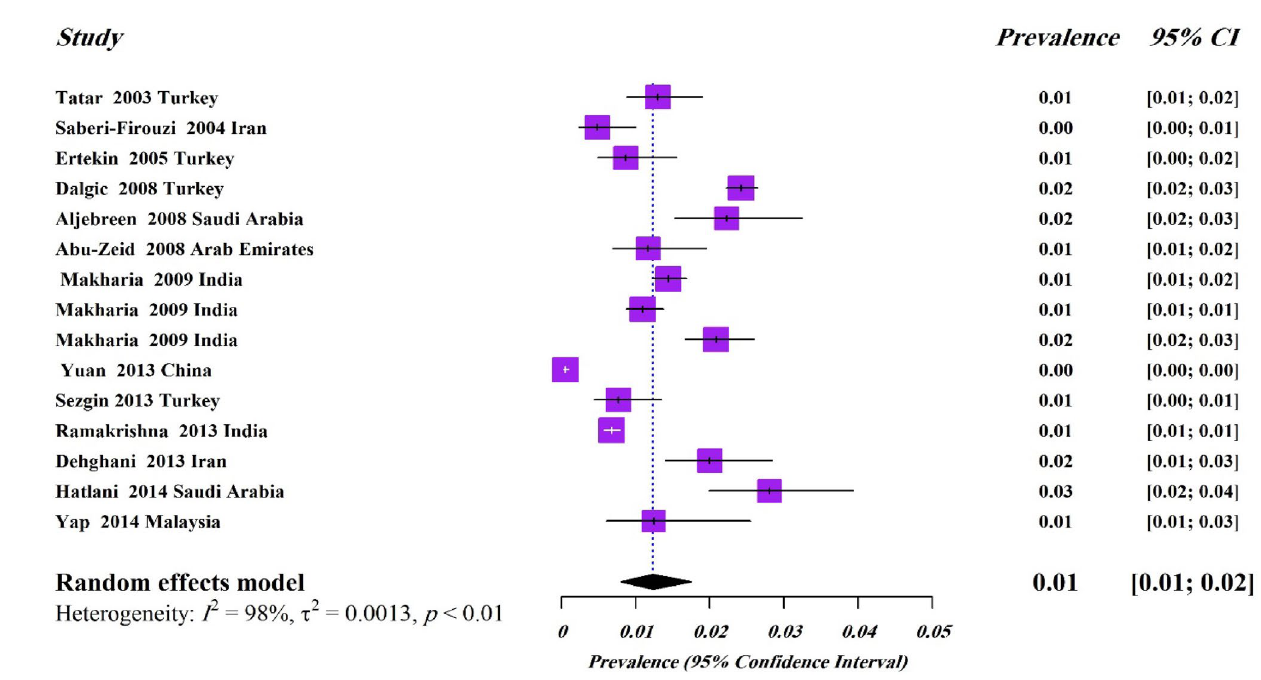
Figure 2. Forest plot for pooled sero-prevalence of CD in Asia–Pacific region among general